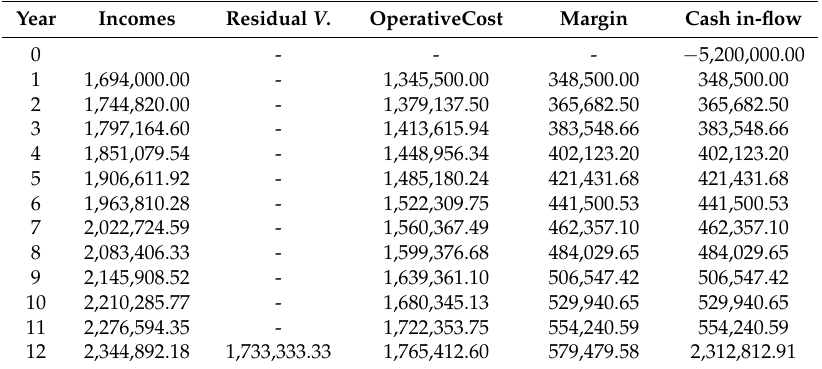
Table 6. Cash flow of the installation of the biomass central for the district.